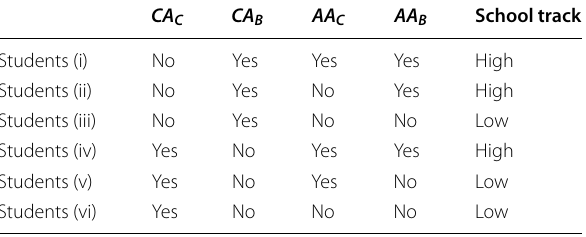
Table 1 The 6 types of students and their corresponding lower secondary